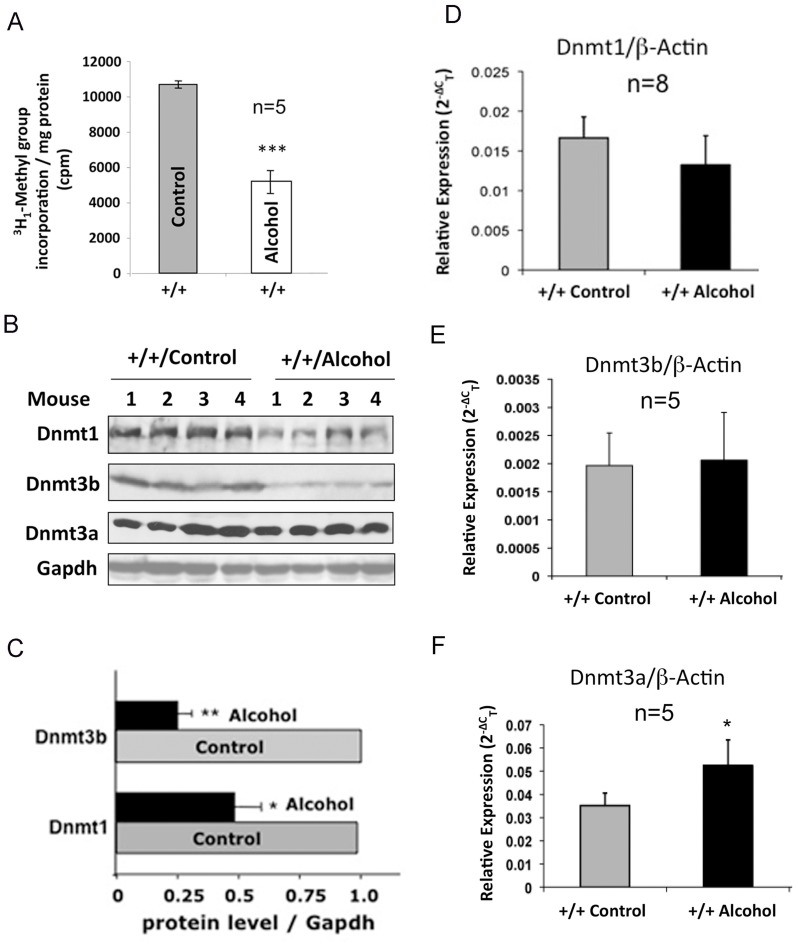
Hepatic Dnmtase activity is reduced in the wild type mice fed the Lieber-DeCarli alcohol diet compared to those fed the control diet for 6 weeks.
A. Dnmtase activity was measured in triplicate in the liver nuclear extracts with poly(dI-dC) as the substrate and 3H1-Ado-Met as cofactor. The 3H1-methyl group incorporation in poly(dI-dC) was measured in a scintillation counter. Each sample was analyzed in triplicate. B, C. Hepatic Dnmt1 and Dnmt3b protein levels are reduced without significant changes in Dnm3a level in mice fed alcohol diet. Liver lysates (250 µg protein) were subjected to Western blot analysis with specific antibodies, signals were quantified using NIH ImageJ software and Dnmt levels were normalized to that of Gapdh. Dnmt1&3b levels in control livers were assigned a value of 1. D–F. qRT-PCR analysis showed significant increase only in Dnmt3a expression upon feeding alcohol diet. Hepatic cDNAs were subjected to qRT-PCR with gene specific primers using SYBR Green chemistry. Each sample was assayed in triplicates. Single, double and triple asterisks represent P-values ≤0.05, ≤0.01 and ≤0.005, respectively. Wild type mice are denoted by +/+.